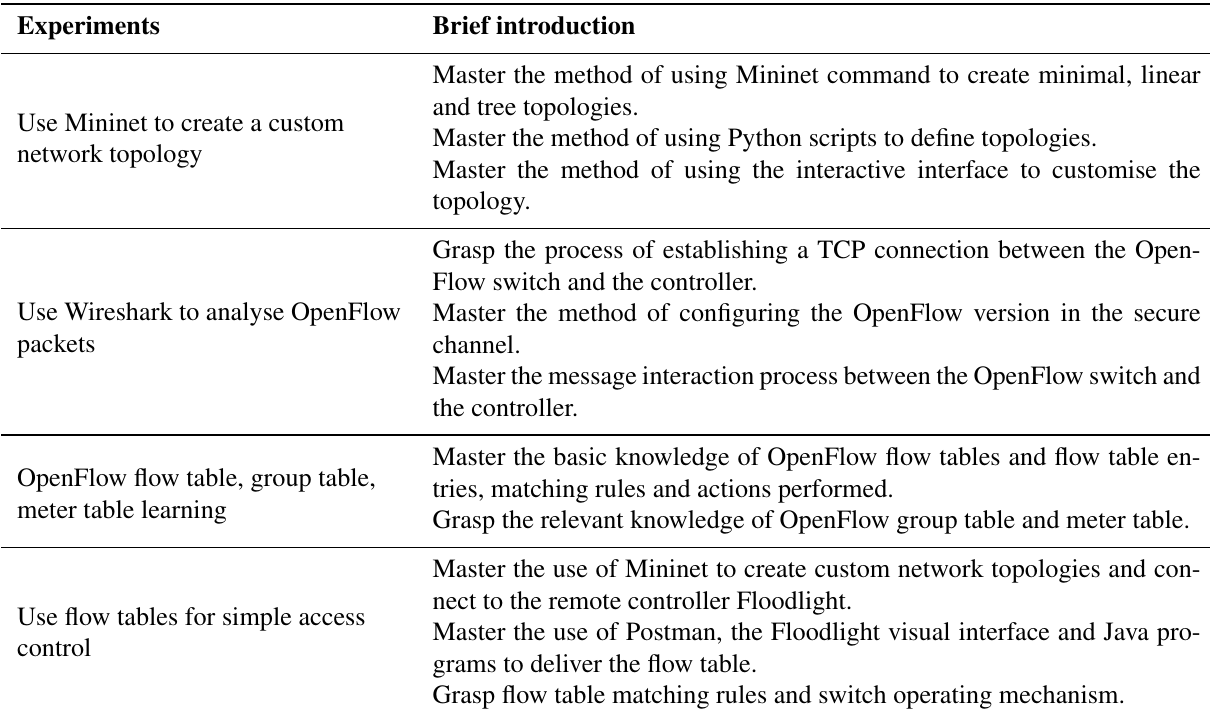
Table 2 Improvement experimental projects